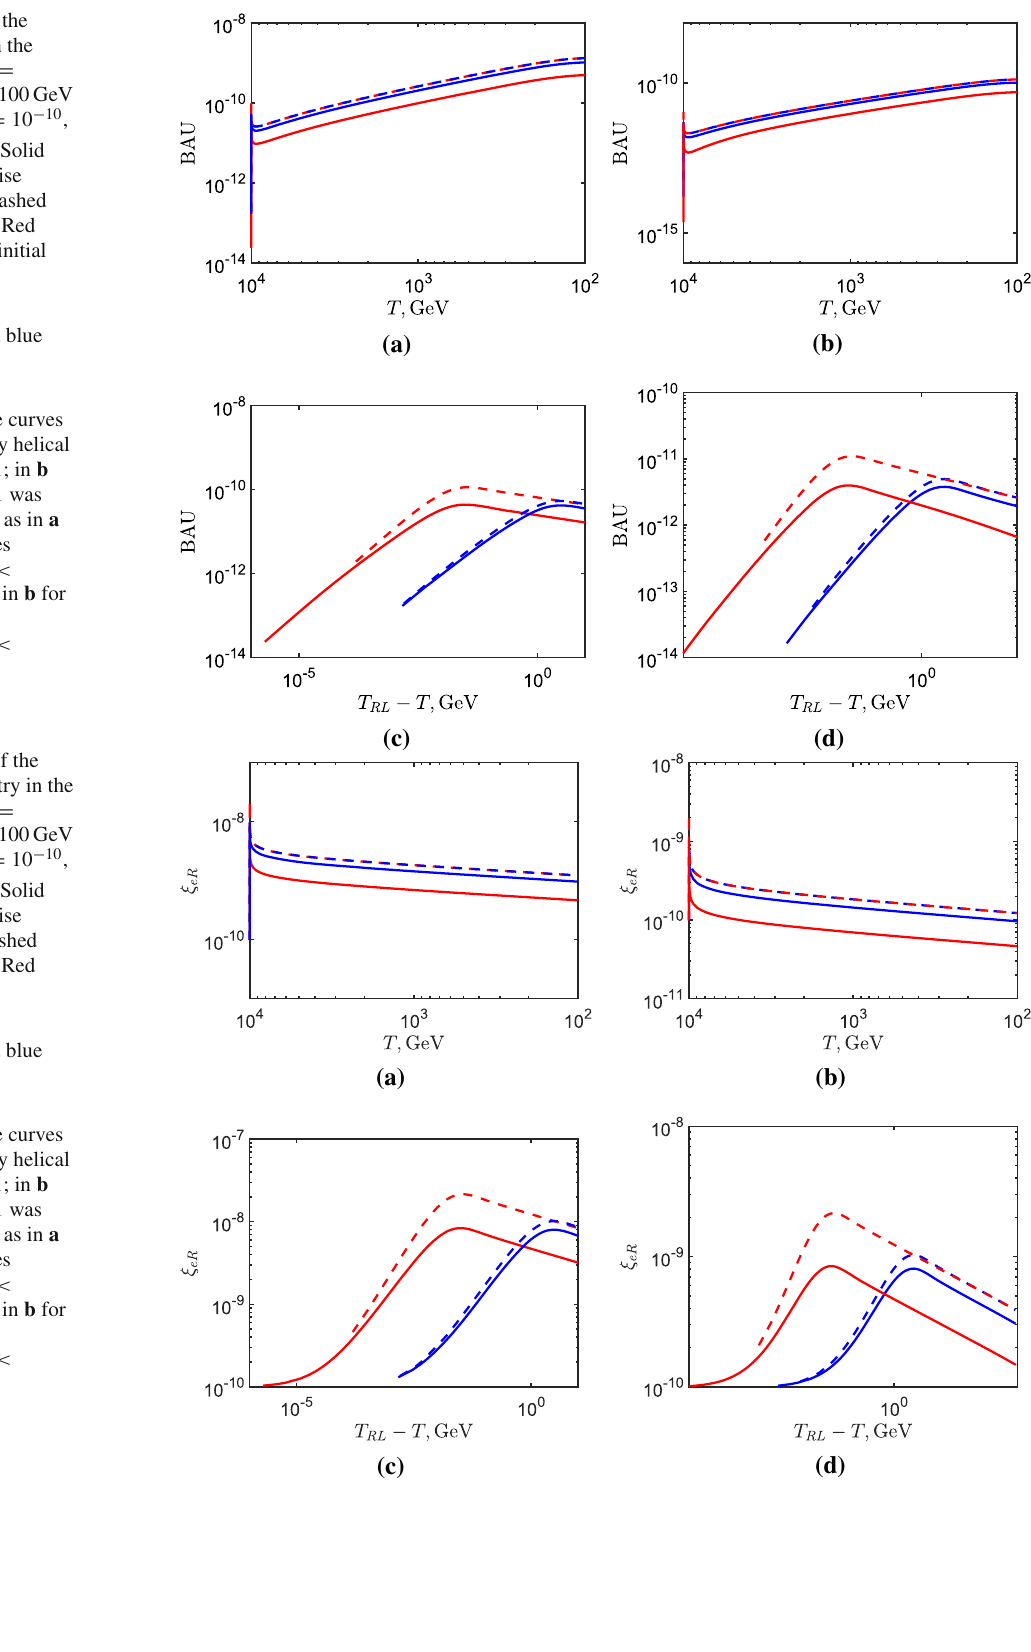
Fig. 1 BAU growth in the symmetric phase within the temperature range T RL = 10TeV ≤ T ≤ T EW = 100GeV ( 0 ) = 10 − 10 , for ˜ k max = 10 − 3 , ξ e R ξ ( 0 ) = 0, and ξ ( 0 ) = 0. Solid e L 0 lines account for the noise contribution, whereas dashed lines are without noise. Red lines correspond to the initial HMF strength ˜ B ( 0 ) = 1 . 4 × 10 − 1 or Y = 7 × 10 26 G and blue B ( 0 ) Y lines correspond to ˜ B ( 0 ) = 1 . 4 × 10 − 2 or Y = 7 × 10 25 G. The curves B ( 0 ) Y a correspond to the fully helical HMF in Eq. (24), q = 1; in b the less helicity q = 0 . 1 was substituted. c The same as in a for small evolution times 10GeV. d The same as in b for small evolution times